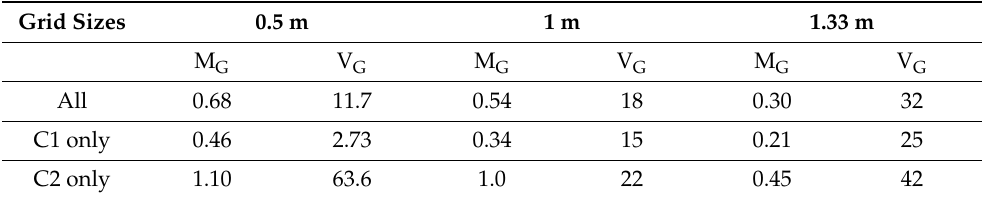
Table 2. Geometric Mean and Variance: direct dispersion–explosion simulations as a function of grid sizes. Results taken from the Phase 3B joint industry project (JIP) [17]. The results are based on maximum overpressure within the module (in experiments and in simulations). Grid Sizes 0.5 m